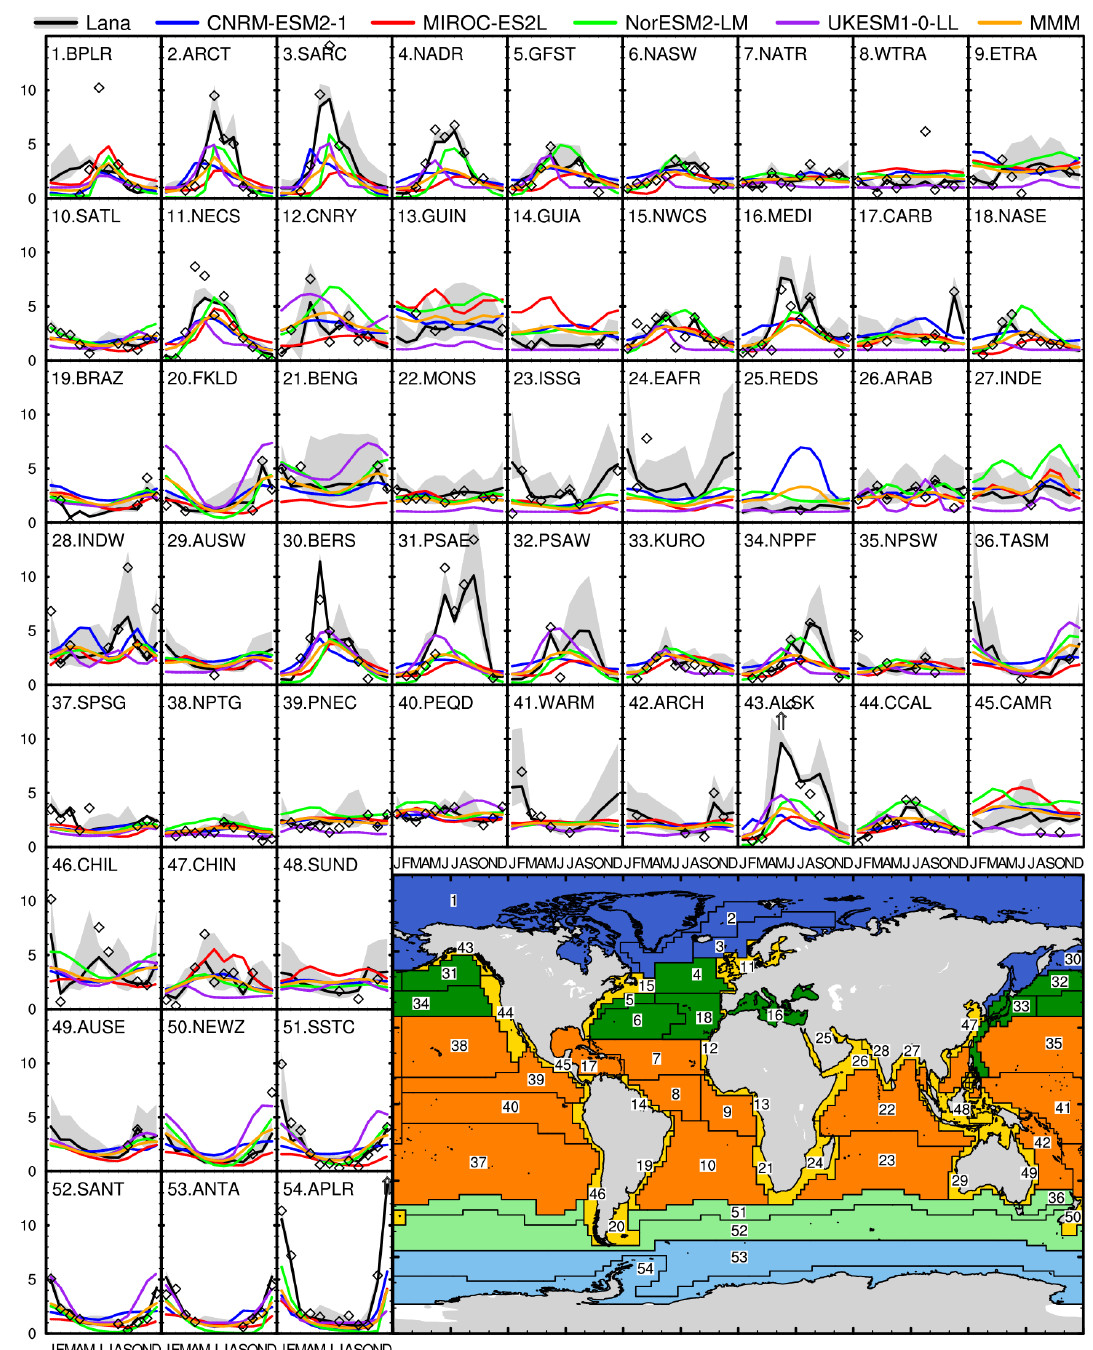
Figure 5. Monthly 1980–2009 area-weighted surface ocean DMS concentration (nM) in the 54 oceanic regions defined by Longhurst (2007), for the models as in Fig. 1 (colour lines) and L11 (black line). Also plotted are other data of L11: (1) minimum and maximum as light grey envelopes, and (2) “Pixel” data, i.e. raw data binned on the 1 ◦ × 1 ◦ grid, as diamonds (note that they are not identical to the data plotted in Fig. 2 of Lana et al. (2011); see text for details). The oceanic region numbering (54 regions) is repeated on the lower right corner map, together with colours according to Longhurst (2007) for the six biomes (dark and light blue: polar N and S, dark and light green: westerlies N and S, orange: trades, yellow: